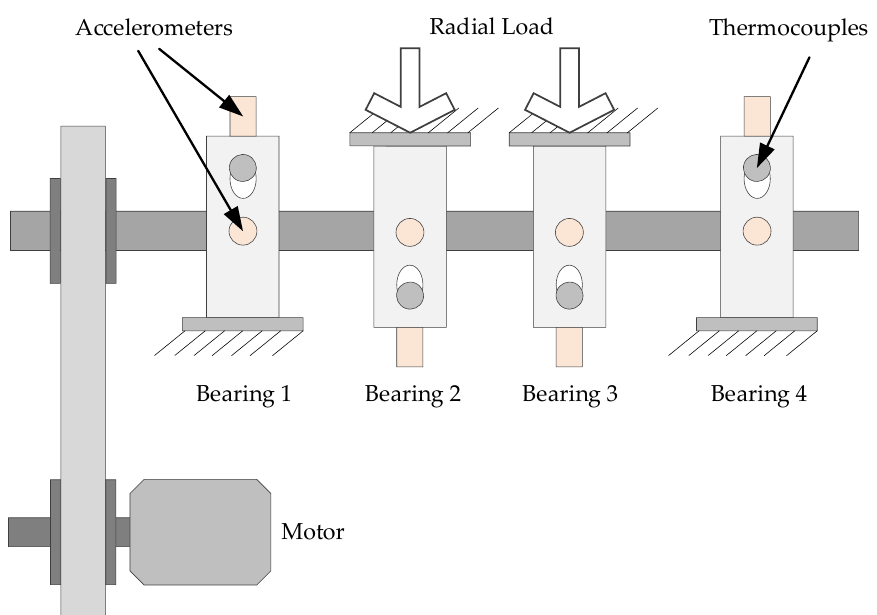
Figure 7. Experimental platform of IMS. The platform mainly consists of four Rexnord za-2115 double row bearings, thermocouples, an AC motor (at 2000 rpm), and vibration sensors (x-axis and y-axis).